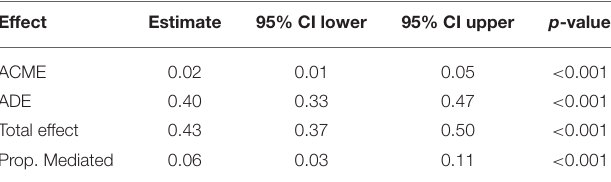
TABLE 6 | Results of the mediation role of work-related